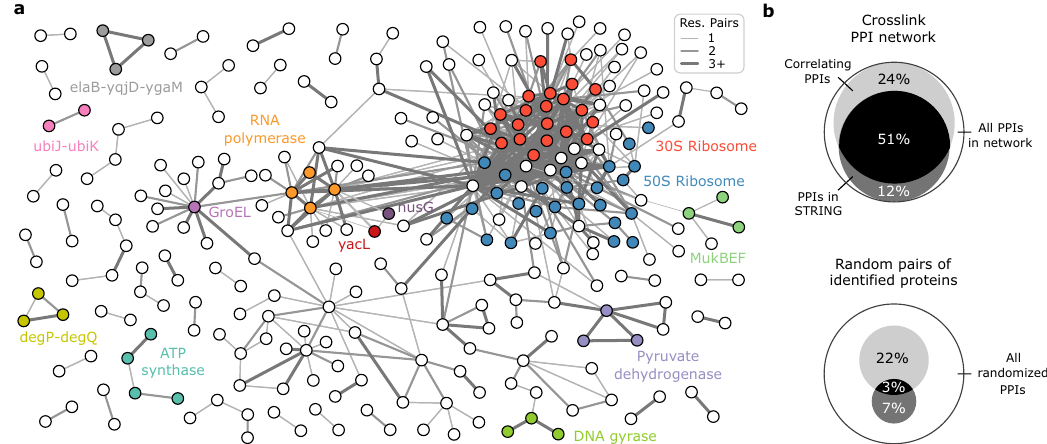
Fig. 3 Heteromeric PPI-FDR leads to high fi delity PPI network in E. coli lysate. a Crosslinking MS-derived PPI network of soluble high molecular weight E. coli proteome. Selected proteins (circles) and protein complexes are highlighted. The proteins AceA and TnaA were removed for clarity. b Characterization of the obtained PPI network in comparison to random PPIs from proteins identi fi ed in coelution data. Shown are the overlaps with STRING database and coelution data (correlation coef fi cient